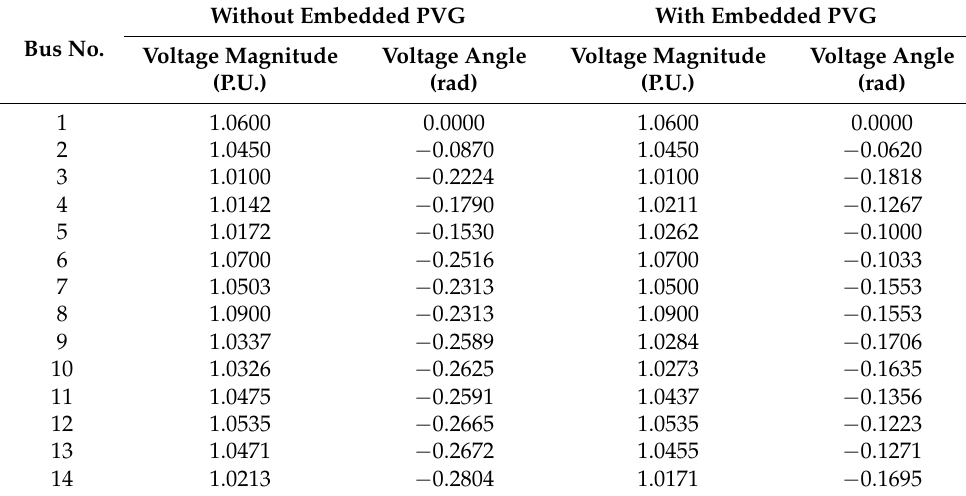
Table 2. Load flow solutions for IEEE 14-bus system under normal operating conditions. Without Embedded PVG With Embedded PVG Bus No. Voltage Magnitude (P.U.)